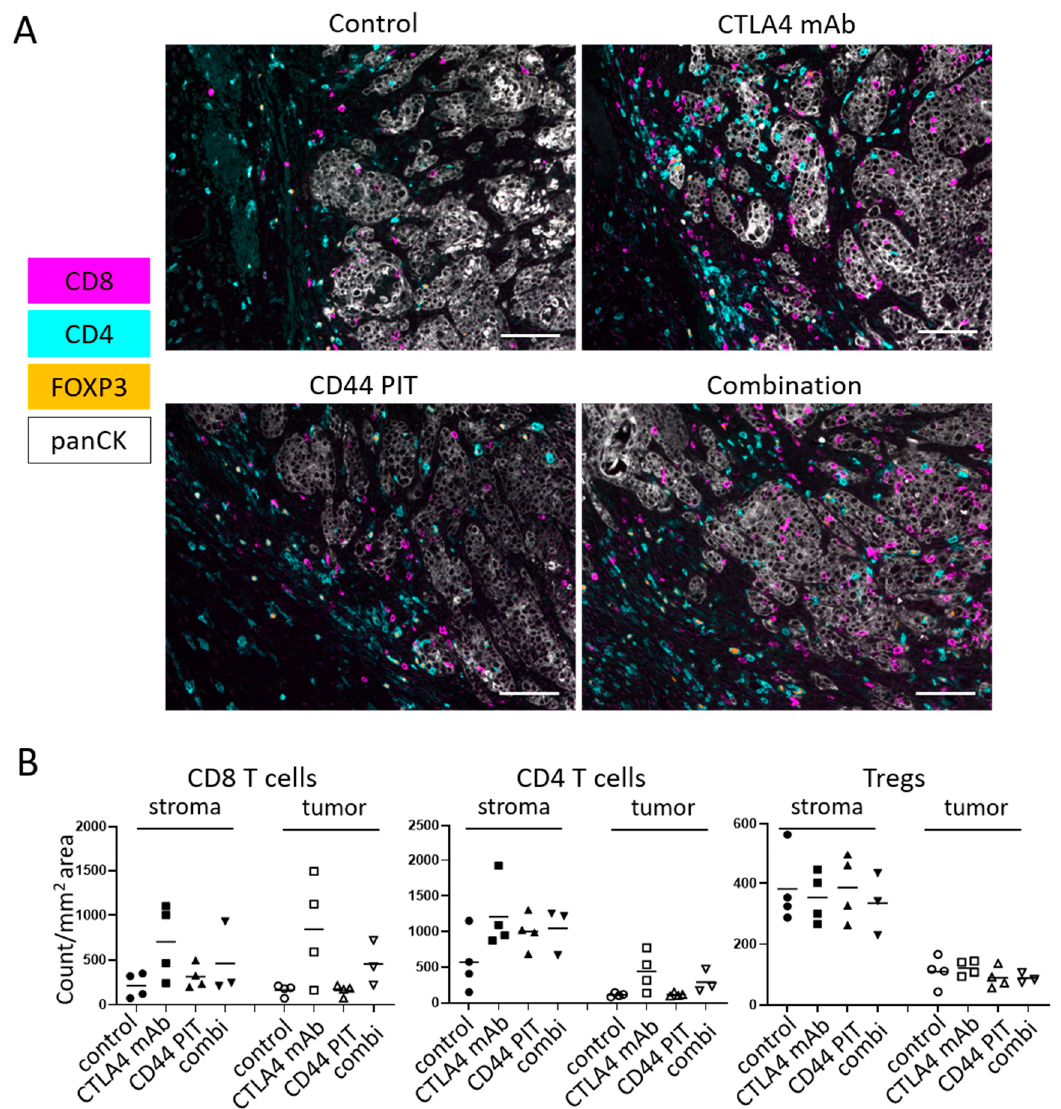
Figure 4. Immune cell infiltration in MOC1 tumors 1 week after NIR-PIT. ( A ) Multiplex IHC images from MOC1 tumors 7 days after treatment. Control, no treatment; CTLA4 mAb, CTLA4 immune-checkpoint blockade only; CD44 PIT, CD44-targeted NIR-PIT only; combination, CD44-targeted NIR-PIT combined with CTLA4 immune-checkpoint blockade. Expressions of CD8, CD4 and FOXP3 are shown in magenta, cyan and orange respectively. The tumor tissues were stained with anti-pan-Cytokeratin, shown in white. The representative pictures from four experiments are shown. ( × 200, scale bar = 100 µ m). ( B ) T cell count in the tumor microenvironment. Cell number of CD8 T cells, non-regulatory CD4 T cells and Tregs in stroma and tumor tissue were counted in multiplex IHC images. Data were shown as cell count per megapixel area. Control, no treatment; CTLA4 mAb, CTLA4 immune-checkpoint blockade only; CD44 PIT, CD44-targeted NIR-PIT only; combi, CD44-targeted NIR-PIT combined with CTLA4 immune-checkpoint blockade (n = 4 for control, CTLA4 mAb and CD44 PIT, n = 3 for combi, no statistically significant difference (One-way ANOVA).